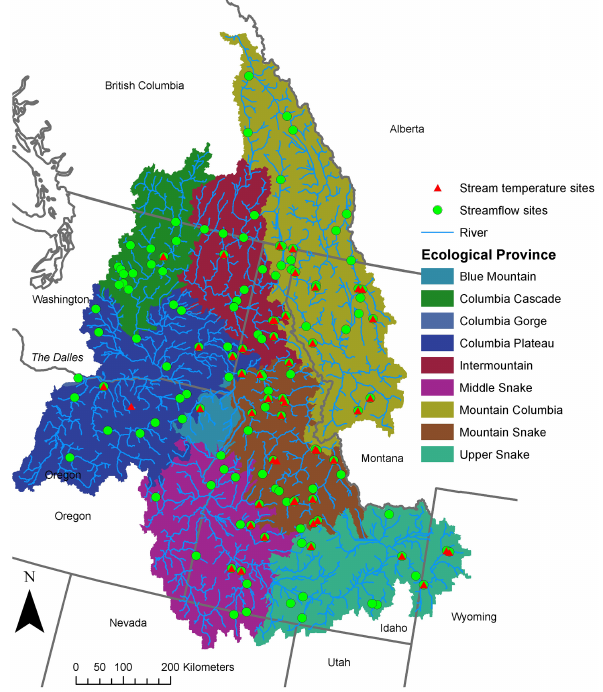
Figure 1. Columbia River basin study area ecological provinces with streamflow and stream temperature gauges for